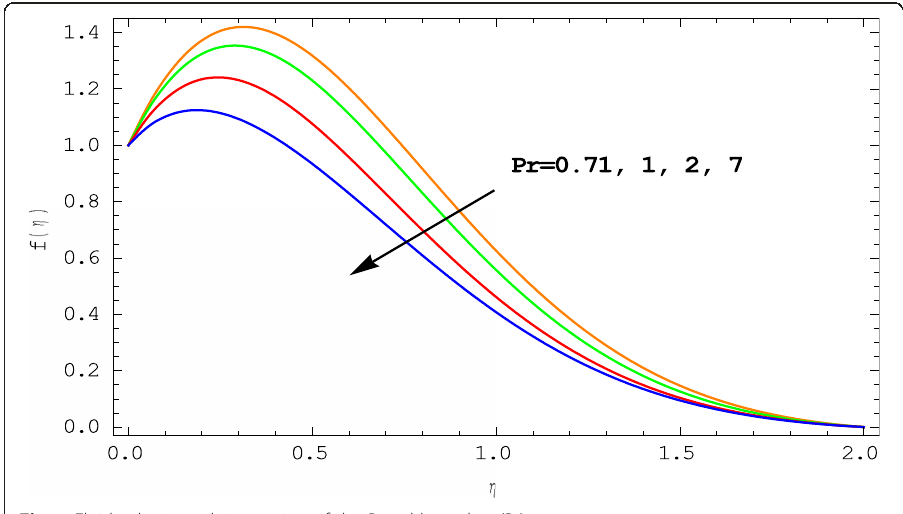
Fig. 7 Fluid velocity with increasing of the Prandtl number